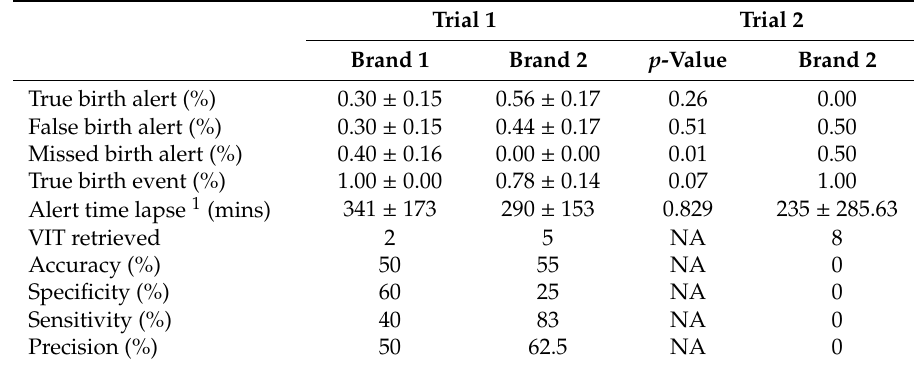
Table 3. Comparison of the performance of two brands of birth alert systems based on vaginal implant tags fitted to pregnant beef cows in extensive production systems (Trial 1 and